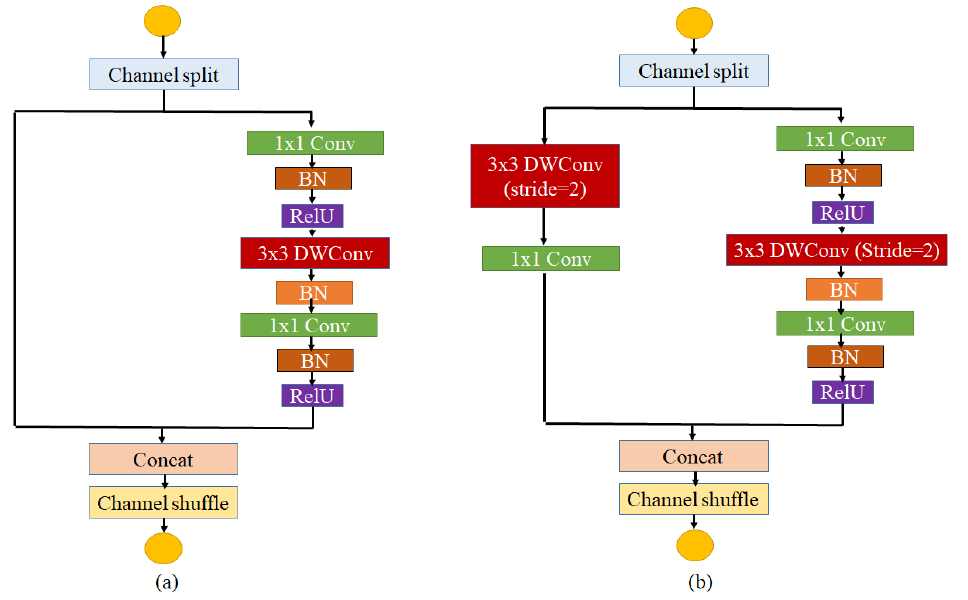
Figure 3. ShuffleNet v2 basic units: ( a ) basic unit, ( b ) basic unit for spatial